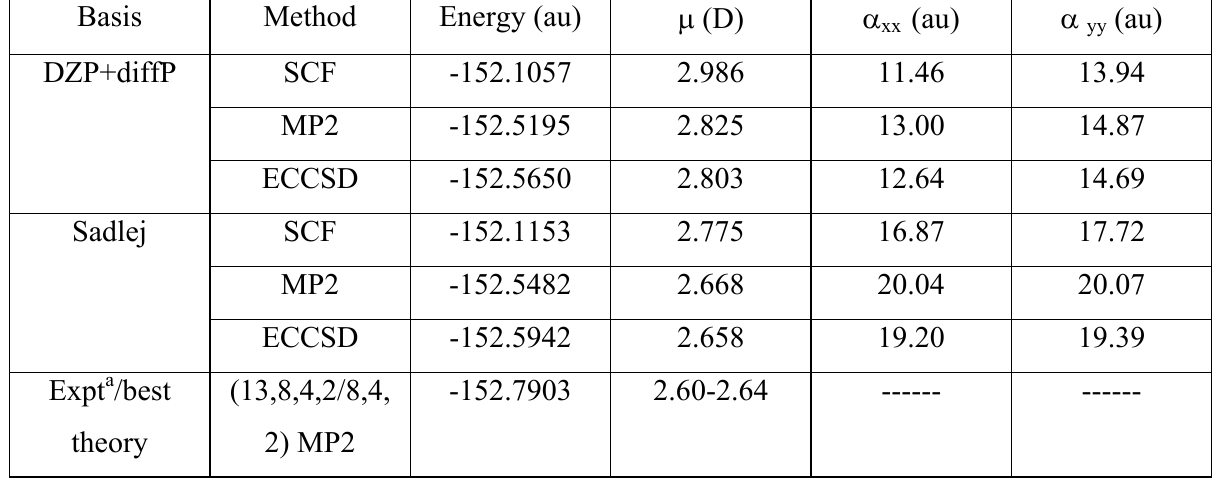
Table 2. Dipole moment and polarizability values for water